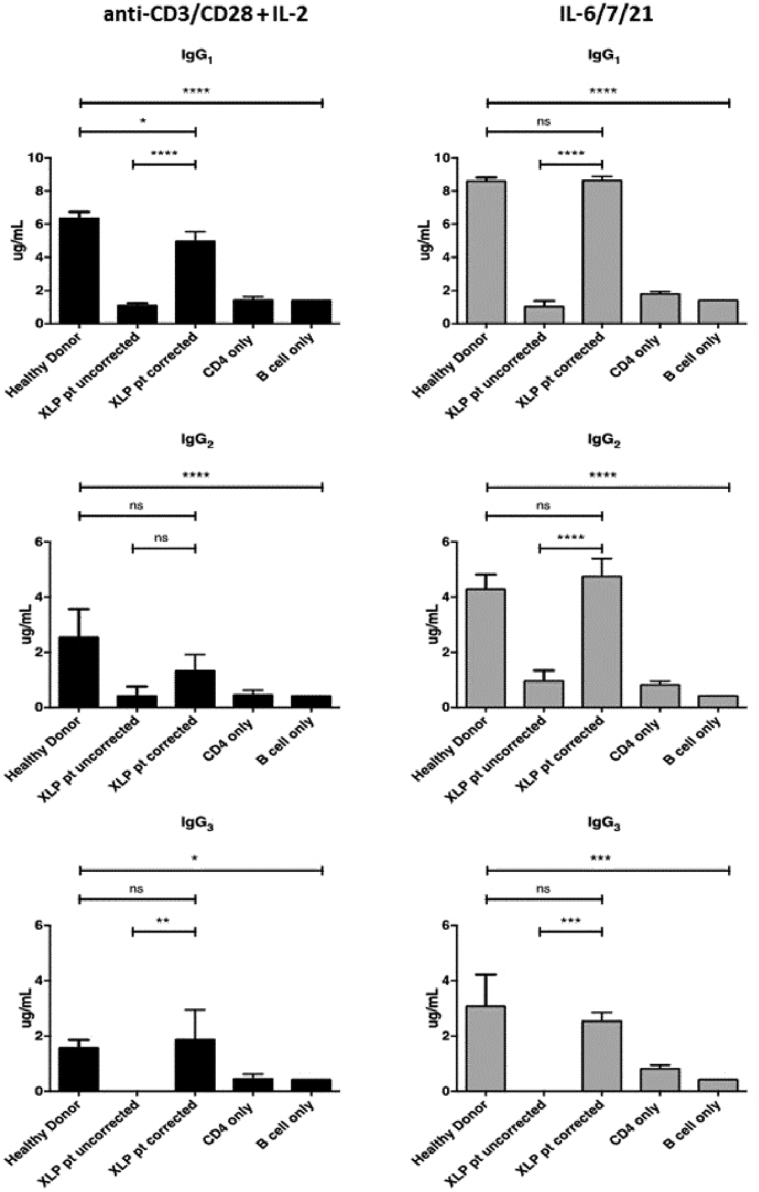
Functional correction of TFH cells from patients with XLP1 in vitro: IgG subclass production. Quantification of IgG subclass levels in supernatants 10 days after coculture of naive CD4+ T cells and allogeneic B cells by means of ELISA. **P < .05, ***P < .001, and ****P < .0001. ns, Not significant.